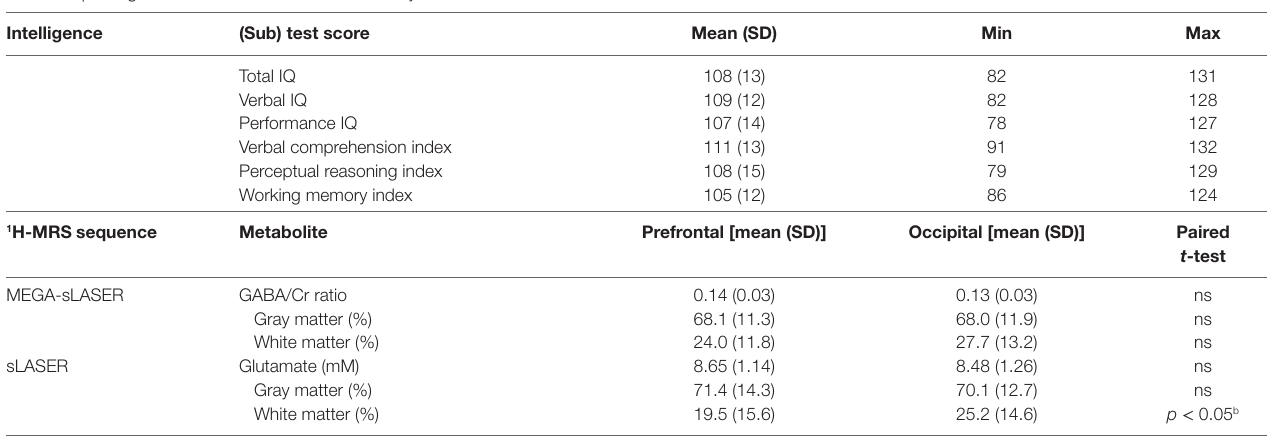
TaBle 1 | Intelligence and brain metabolites in healthy individuals. a